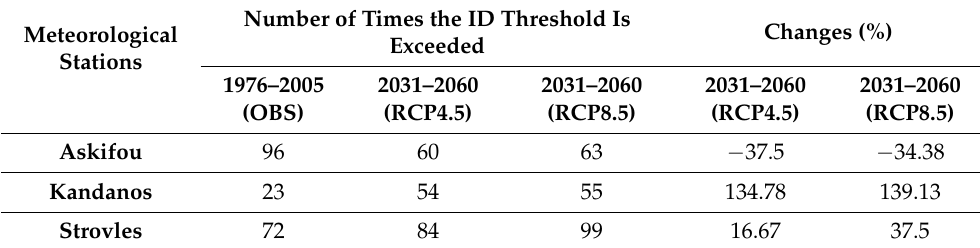
Table 2. Number of times the ID thresholds are exceeded in the control and future periods.